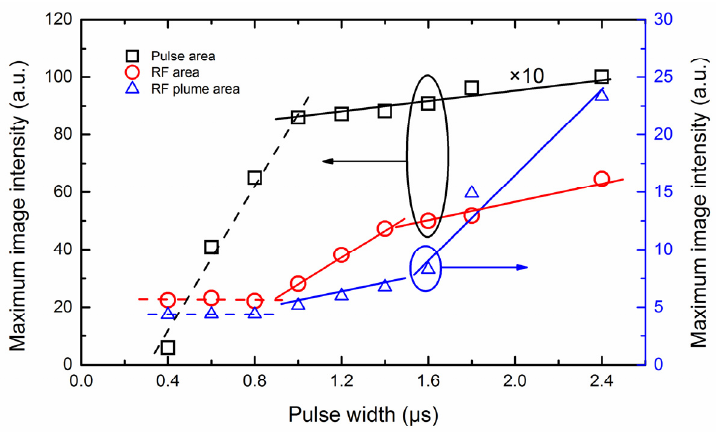
Figure 3. Time-dependent discharge image intensity of pulsed discharge, RF discharge, and plasma plume with duration of voltage pulse.